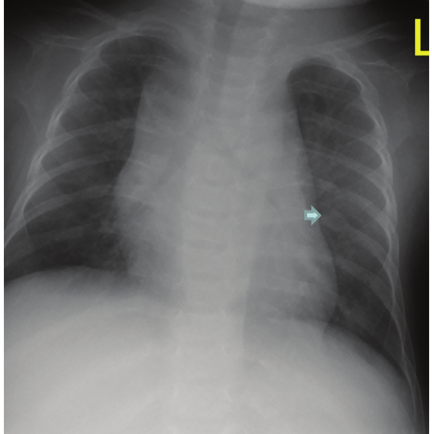
Figure 2: Anteroposterior thorax radiograph generalized osteo- porosis associated with thin and somehow gracile and short ribs. Note callus formation on the 7th right rib